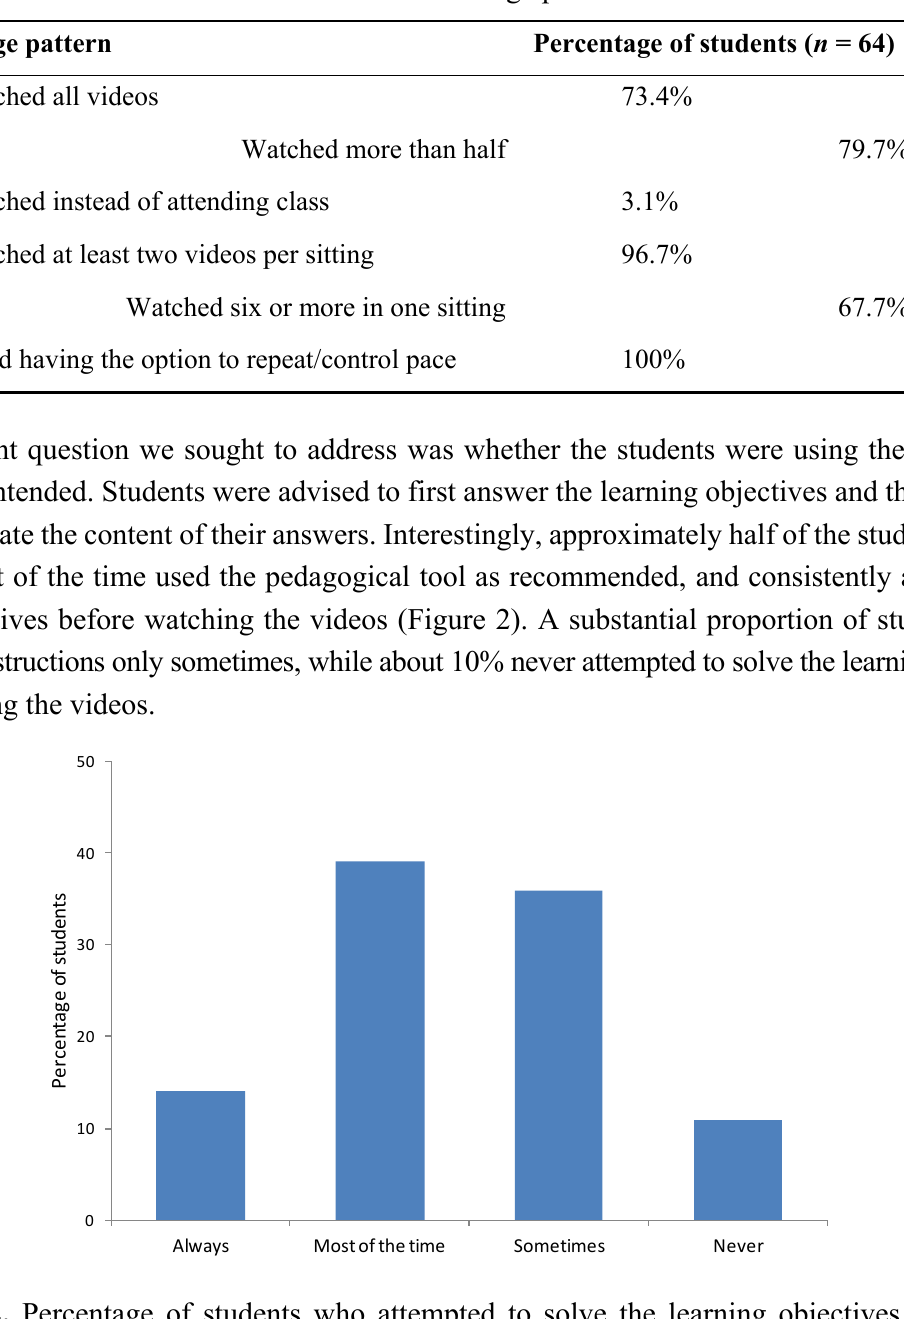
Table 2. Students’ usage patterns.